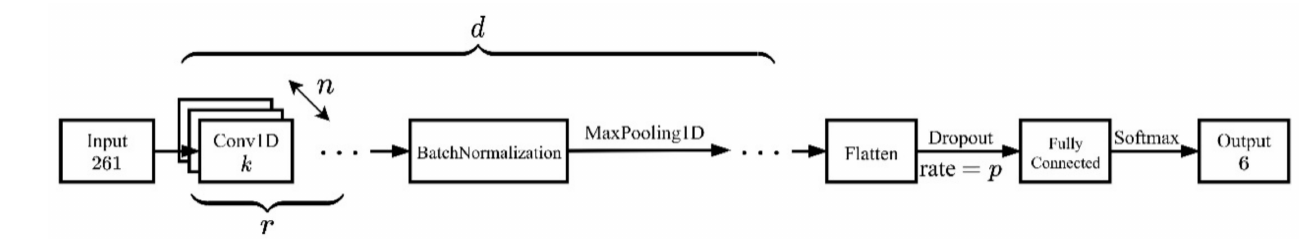
Figure 3. Basic architecture of the convolutional neural network model. n features are extracted by the 1D convolution Conv1D of kernel size k , and Conv1D is repeated r times, followed by a batch normalization layer and a max-pooling layer. The pooling process is repeated d times, and then flattened with a dropout rate p . The flattened neurons are then fully connected, and output to six classes using the soft-max